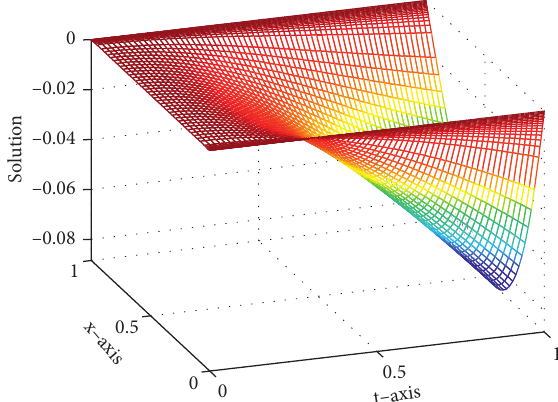
Figure 3: The numerical solution profile for Example 3 when N � 64 , M � 64 , ε � 10 − 2 , and μ � 10 − 10 .